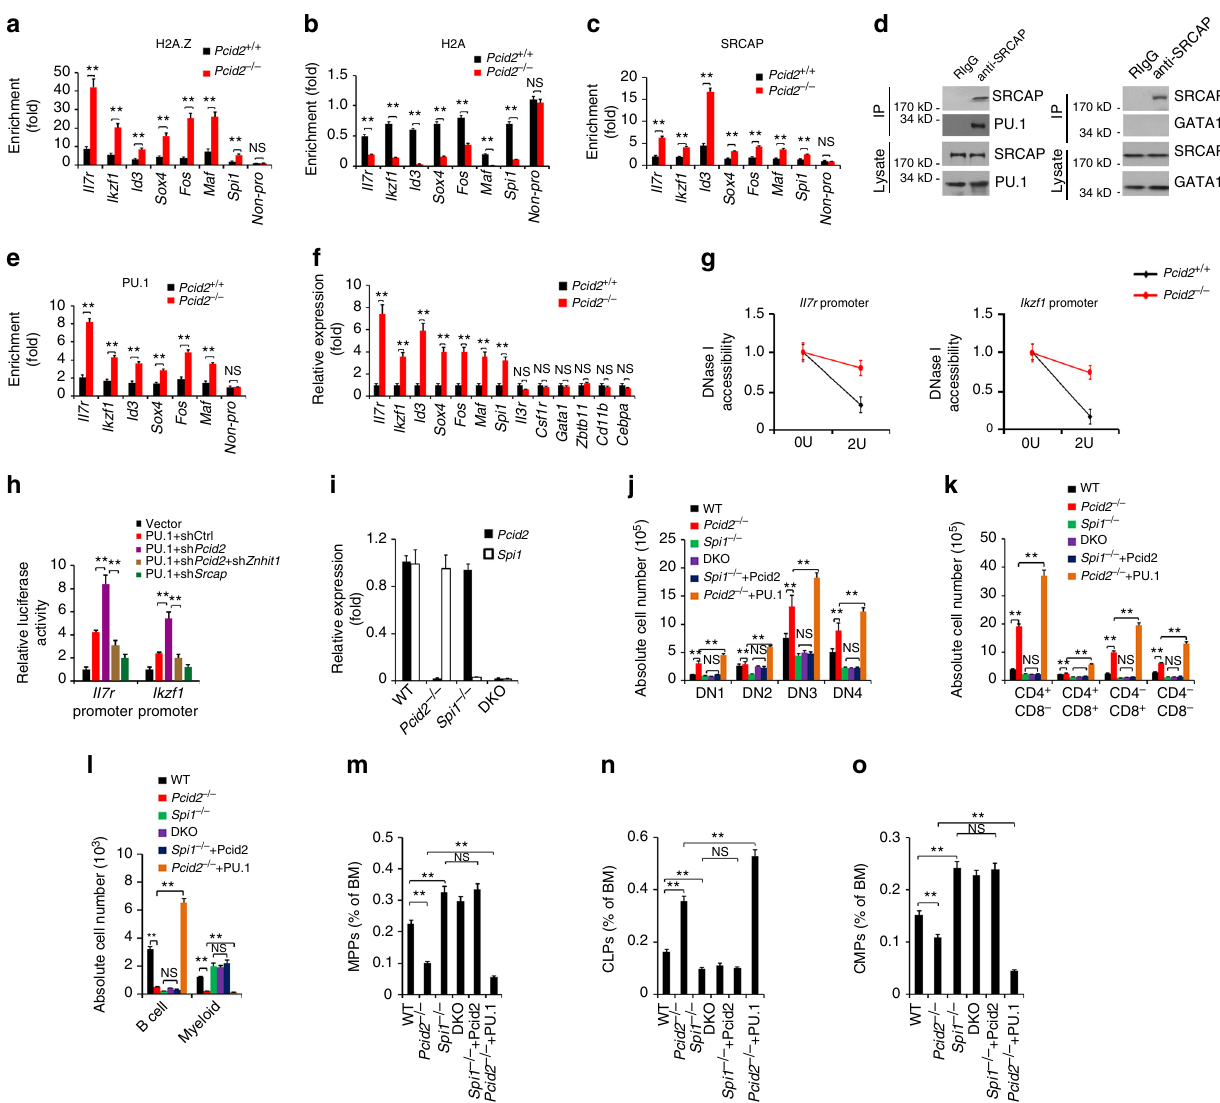
Fig. 5 Pcid2 de fi ciency causes H2A.Z deposition to lymphoid fate regulator genes in MPPs. a Sorted MPPs were lysed for ChIP assays. Indicated promoters were examined by qPCR. Signals were normalized to input DNA. Fold enrichment was calculated comparing with negative control (Non-pro locus). Results are shown as means ± S.D. b , c Indicated MPPs were lysed for ChIP assays with anti-H2A b or anti-SRCAP c antibody as in a . d MPP lysates were incubated with anti-SRCAP antibody. SRCAP-associated PU.1 and GATA1 were detected by immunoblotting. IP immunoprecipitation, RIgG rabbit IgG. e Indicated MPPs were lysed for ChIP assays with anti-PU.1 antibody as in a . f Expression levels of lymphoid fate regulator genes and myeloid fate regulator genes were assessed in sorted MPPs by quantitative RT-PCR. g Nuclei of MPPs were extracted for DNase I digestion assay. Chromatin accessibility were quantitated by qPCR. h Flag-PU.1, pTK and pGL3- Il7r promoter or pGL3- Ikzf1 promoter, together with the indicated shRNAs, were transfected into 293T cells for luciferase assays. Results are shown as means ± S.D. i Pcid2 and Spi1 DKO were generated as described in Methods section. Bone marrow mRNA levels of Pcid2 and Spi1 were measured by qPCR. j In vitro lymphoid differentiation assays of the indicated LMPPs were conducted as in Fig. 2c. For Pcid2 or PU.1 restoration, 1 × 10 3 HSCs were isolated from the BM of Spi1 − / − or Pcid2 − / − mice and infected with pMY-GFP-Pcid2 or pMY-GFP-PU.1 containing retrovirus and transplanted into lethally irradiated recipient mice together with 5 × 10 6 helper cells. k Cells were sorted, infected and cultured as in j and used Flt3 ligand alone thereafter. l B-cell and myeloid differentiation assays of the indicated MPPs in vitro were conducted as in Fig. 2e. m Indicated HSCs as described in j were sorted, infected and transplanted for 16 weeks. m Percentages of MPPs, n CLPs and o CMPs from the BM of indicated mice were analysed by fl ow cytometry. Results are shown as means ± S.D. n = 6 for each group. ** P < 0.01. Student ’ s t -test was used as statistical analysis. QPCR primer pairs are shown in Supplementary Table 1. Data are representative of at least three independent